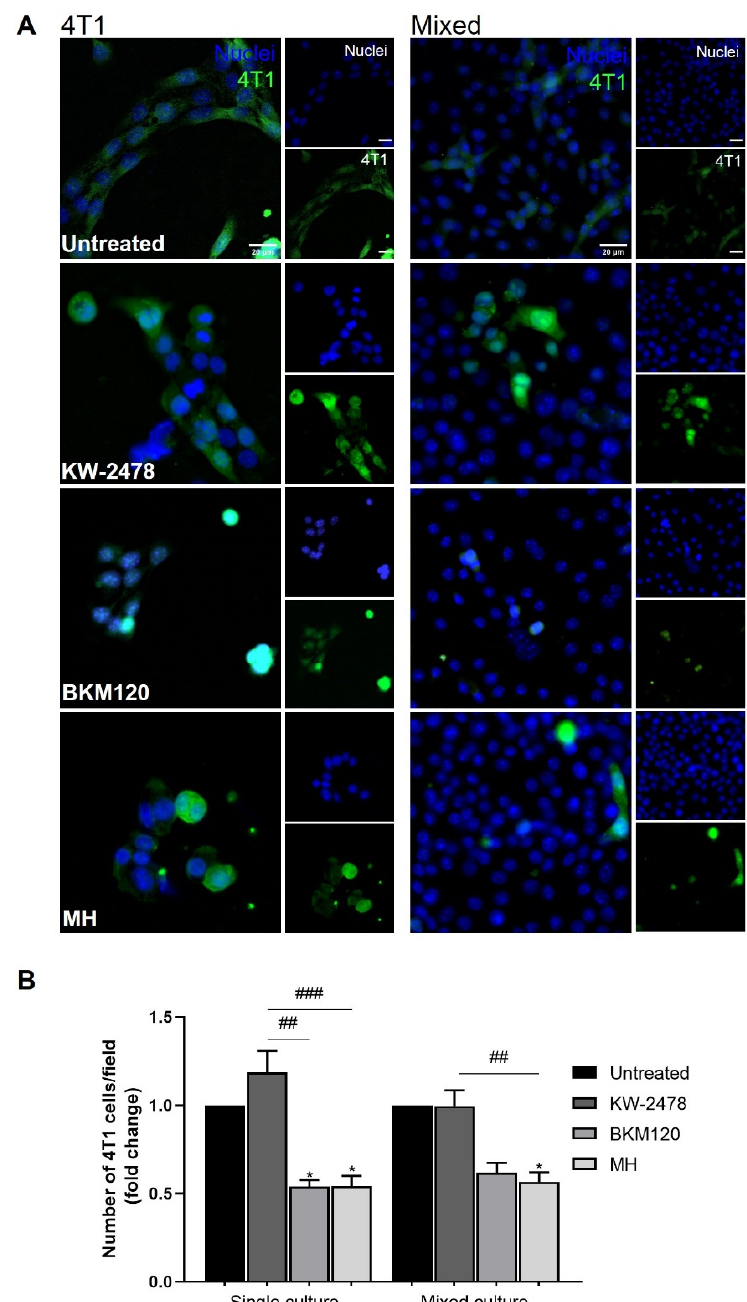
Figure 6. BKM120 and MH decrease the number of adherent 4T1 cells. Confluent monolayers of b.End5 under physiological laminar non-pulsatile shear stress were exposed to 4T1 cells (previously labelled with CellTracker™ DMFDA Green Dye) and treated with BKM120 (0.1 µ M), KW-2478 (1 µ M), MH (1 µ M), or DMEM (untreated), for 24 h, and the adhesion of 4T1 in single and in mixed cultures was evaluated. Hoechst 33342 was used as counterstaining for nuclei (blue). Scale bar: 20 µm. ( A ) Immunofluorescence analysis revealed that BKM120 and MH promote the decrease in 4T1 adherence, particularly to the endothelium, confirmed by ( B ) quantitative analysis of 4T1 adherent cells, normalised to the respective control (untreated cells). Data are represented as mean ± SEM of three independent experiments, where 10 fields/condition were evaluated. Statistical significances are denoted as * p < 0.05 for treated vs. untreated conditions between the same culture type and ## p < 0.01 and ### p < 0.001 between the indicated conditions. By quantifying the number of 4T1 adherent cells per field, it was possible to observe that the drugs presented a similar effect on 4T1 behaviour in single and mixed cultures.